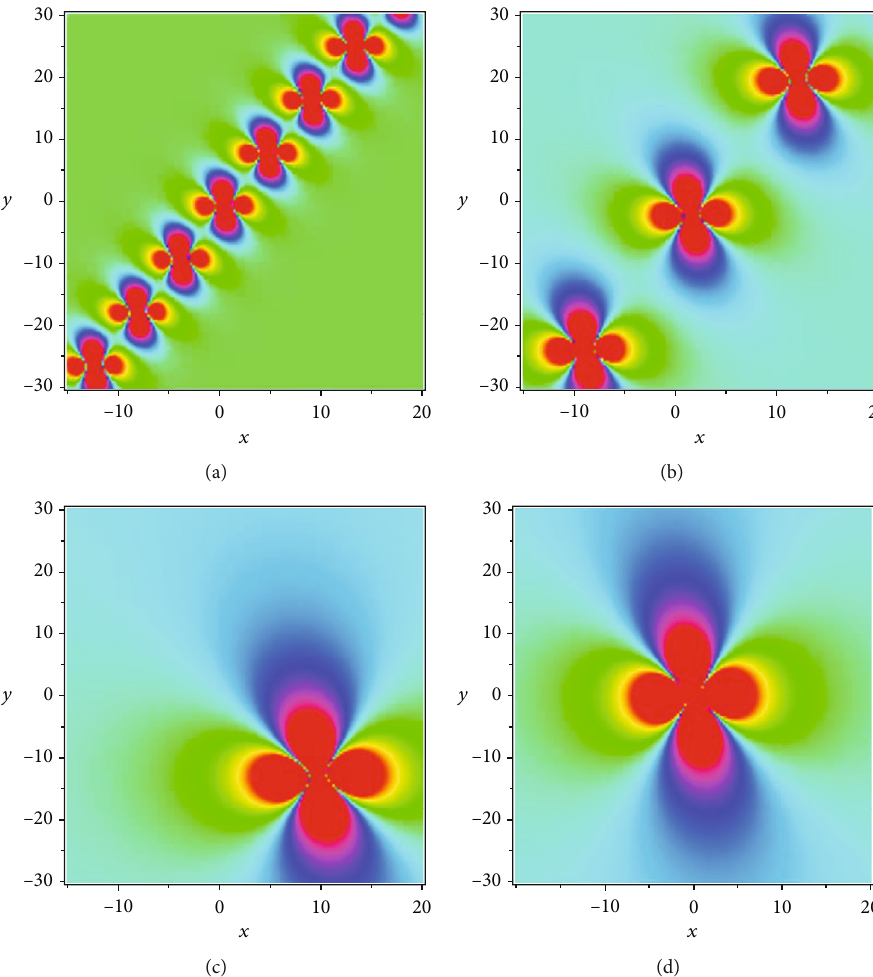
Figure 4: The degeneration of 1-breather (14) with γ = 0 : 1 and δ = 0 : 7 : (a) α = β = 1/4 , (b) α = β = 1/10 , (c) α = β = 1/60 , and (d)